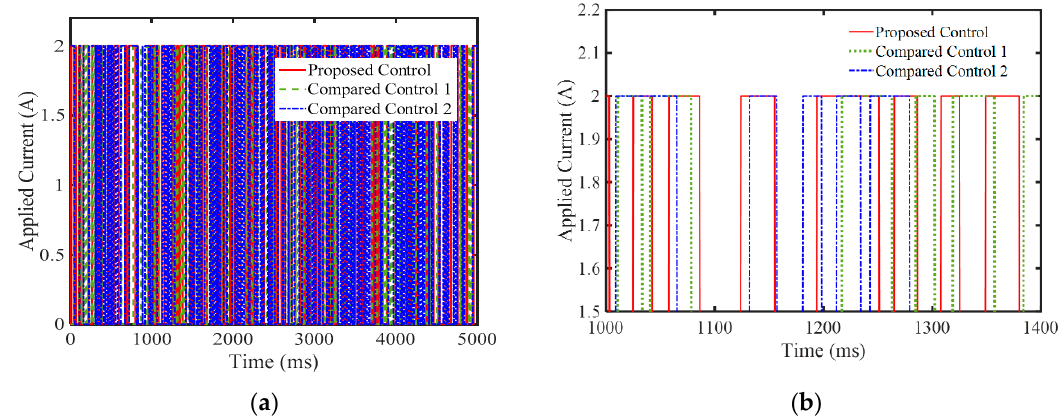
Figure 8. Applied current of random-step-wave excitation: ( a ) general view; and ( b ) large view.